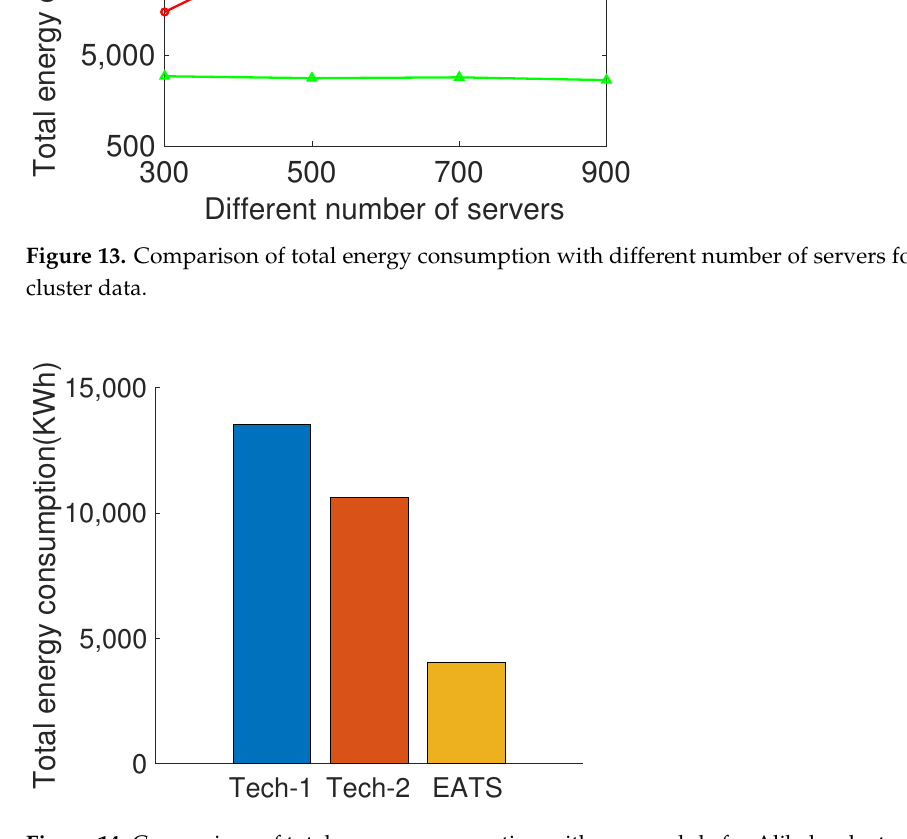
Figure 14. Comparison of total energy consumption with one module for Alibaba cluster